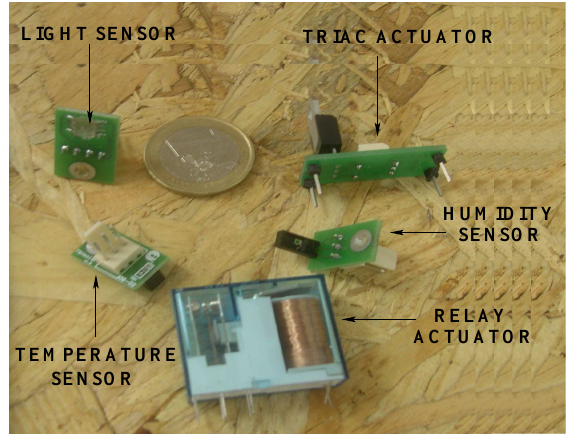
Figure 5. Sensor and actuator boards designed for its used on the NOD485